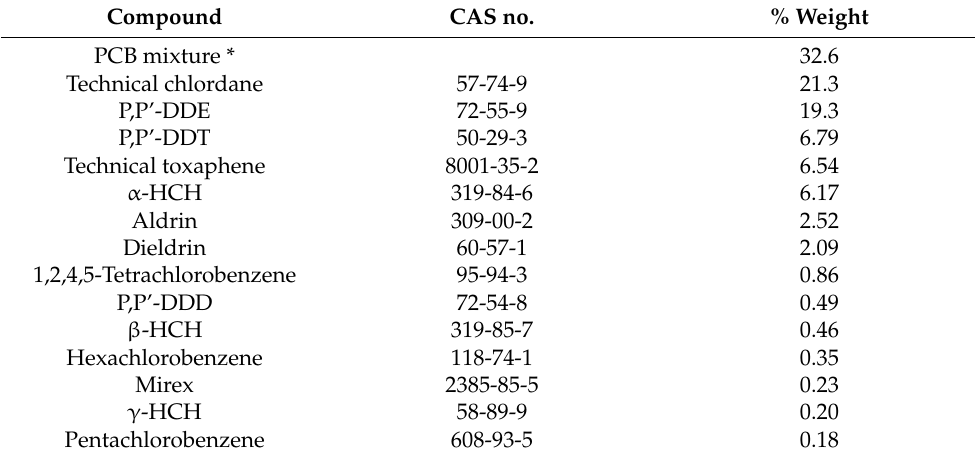
Table 1. Composition of the organochlorine mixture [22] used in this study. Compound CAS